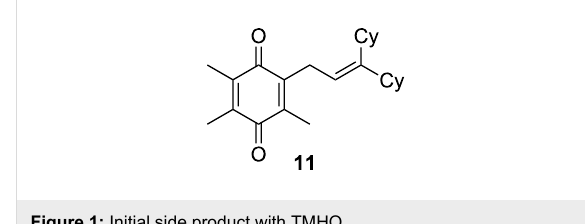
Figure 1: Initial side product with